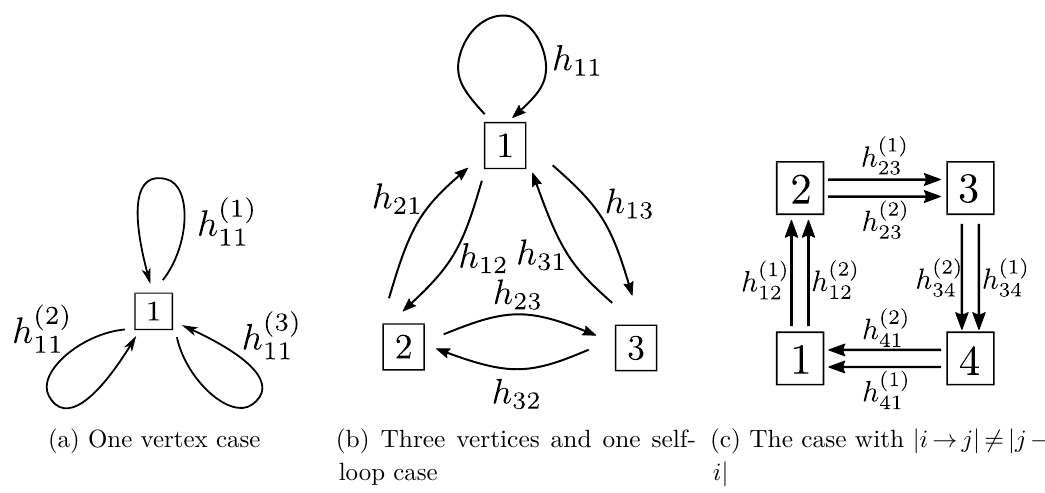
Figure 1. Three examples of the quiver diagrams. They have | Q 0 | vertices and | Q 1 |